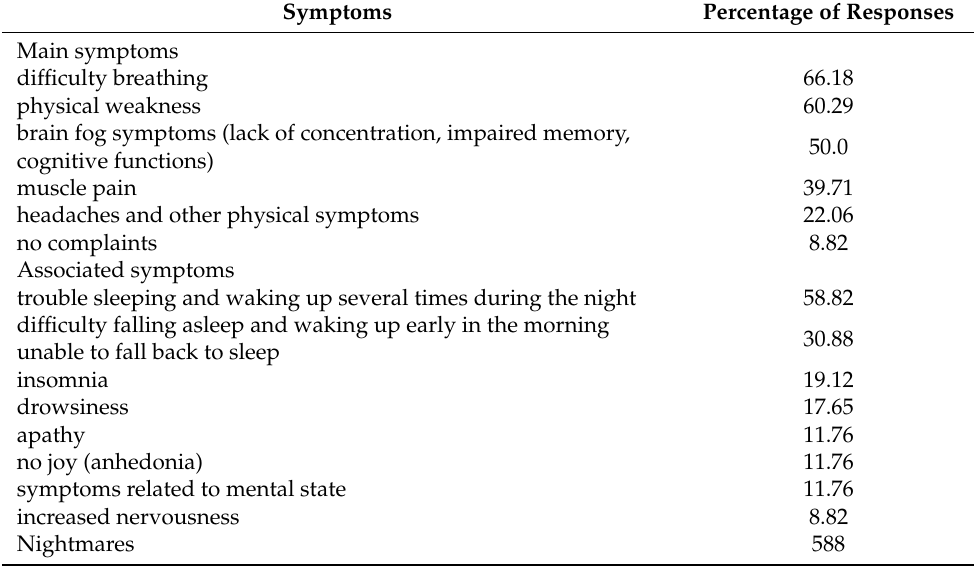
Table 1. Health status in the subjects starting